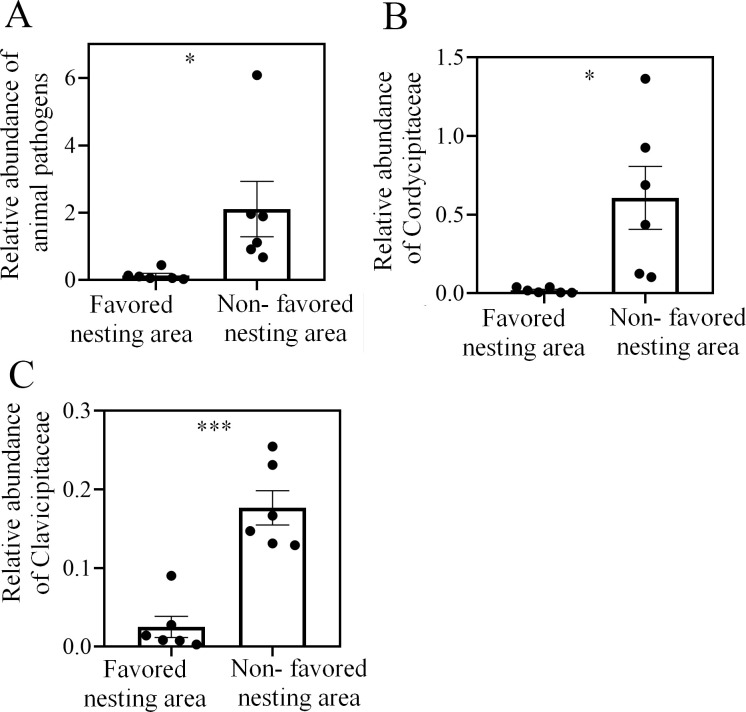
Diversity of fungi is greater in soil from areas not favored by nesting S. invicta queens.(A) Relative abundance of fungi that are pathogenic to animals (±SE, n = 6 biological replicates, independent-sample t tests). (B) and (C) Relative abundance of Clavicipitaceae and Cordycipitaceae (±SE, n = 6 biological replicates, independent-sample t tests). Asterisks indicate significant differences (*P < 0.05, **P < 0.01, ***P < 0.001).